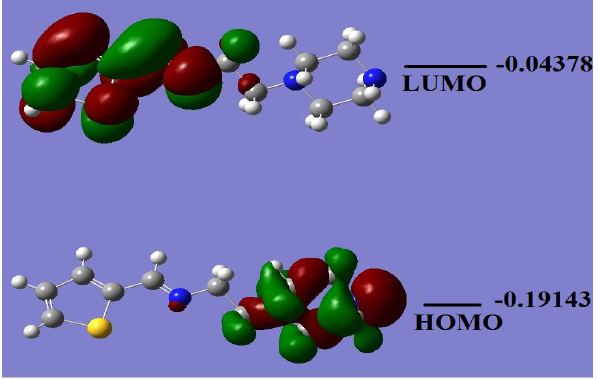
Figure 5. HOMO/LUMO molecular orbitals plot of L2 .